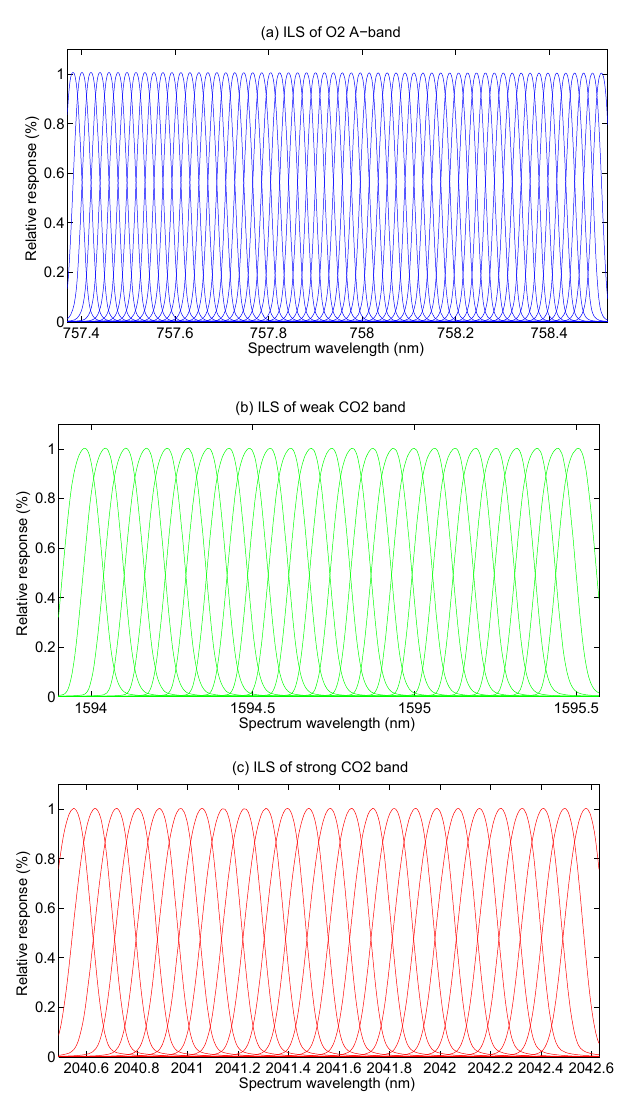
Figure 3. ILS of the first 60 channels in the O 2 A-band (a) , and the first 25 channels in the WCO 2 (b) and the SCO 2 (c) bands of footprint